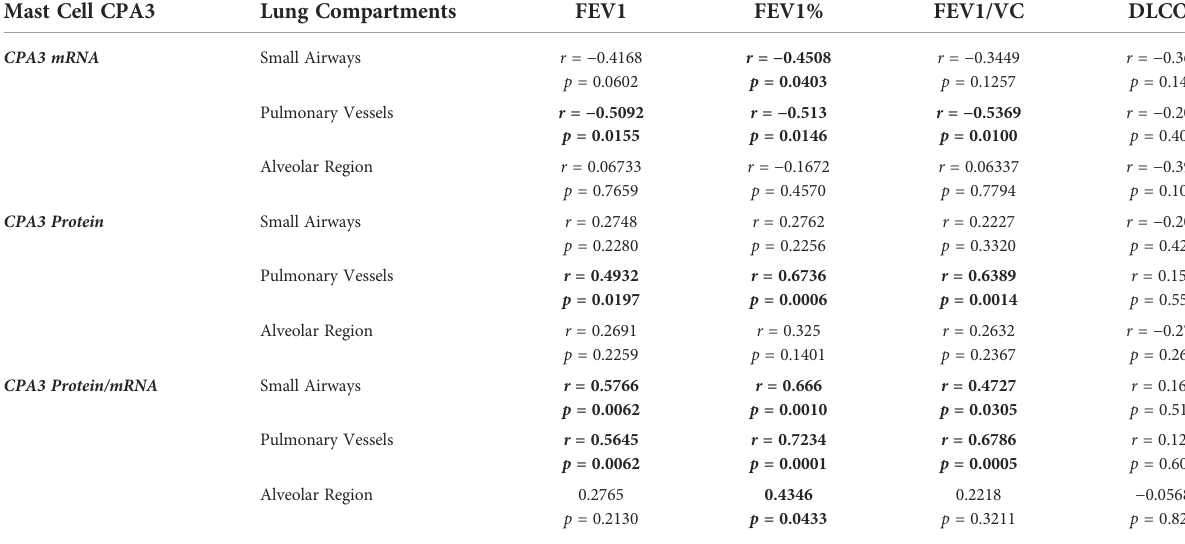
Table 2. Correlations between mast cell CPA3 and lung function parameters.